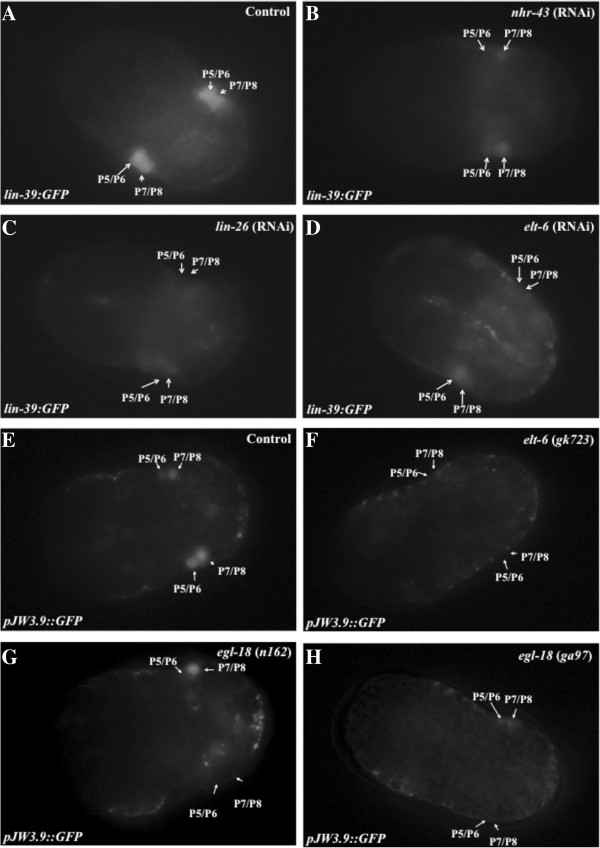
NHR-43, LIN-26, ELT-6 and EGL-18 are necessary for lin-39::GFP expression in the embryo. A–D) GFP expression in embryos derived from smg-1; deIs4(lin-39::GFP) animals treated for control RNAi (empty vector, panel A) or for RNAi against transcription factor genes B)nhr-43;C)lin-26 or D)elt-6. E – H) GFP expression in embryos carrying pJW3.9::GFP in a wild-type background (E) or in animals carrying mutations in elt-6(F) or egl-18(G and H). Embryos shown are at the ‘bean’ stage of embryogenesis (~360 minutes). All photos were taken under identical exposure settings. Note that before the individual P cells interdigitate at the ventral midline, the cells are referred to by their possible fates (i.e., P5/6 L and P5/6R), and there are two GFP-expressing cells on the left side and two on the right.